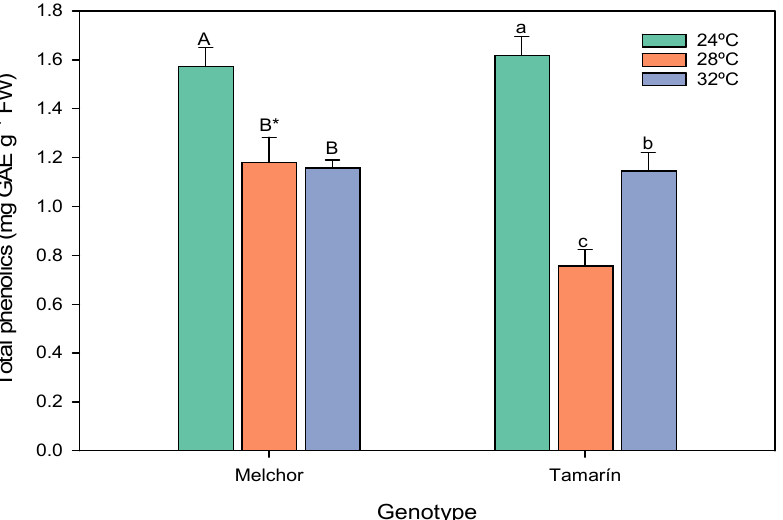
Figure 4. Effect of temperature (24 ◦ C, 28 ◦ C, and 32 ◦ C) on total phenolics of Melchor and Tamar í n fruits. The data are presented as the treatment means ( n = 6) ± S.E. Different lowercase letters indicate significant differences between temperatures in Melchor and different uppercase letters indicate significant differences between temperatures in Tamar í n. * Denotes significant differences between two cultivars grown under the same temperature conditions.